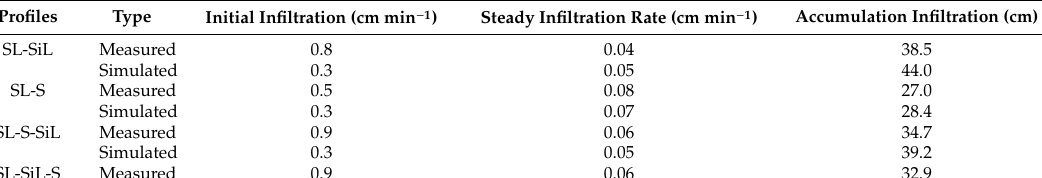
Table 5. Statistics of the infiltration characteristics of various soil profiles.